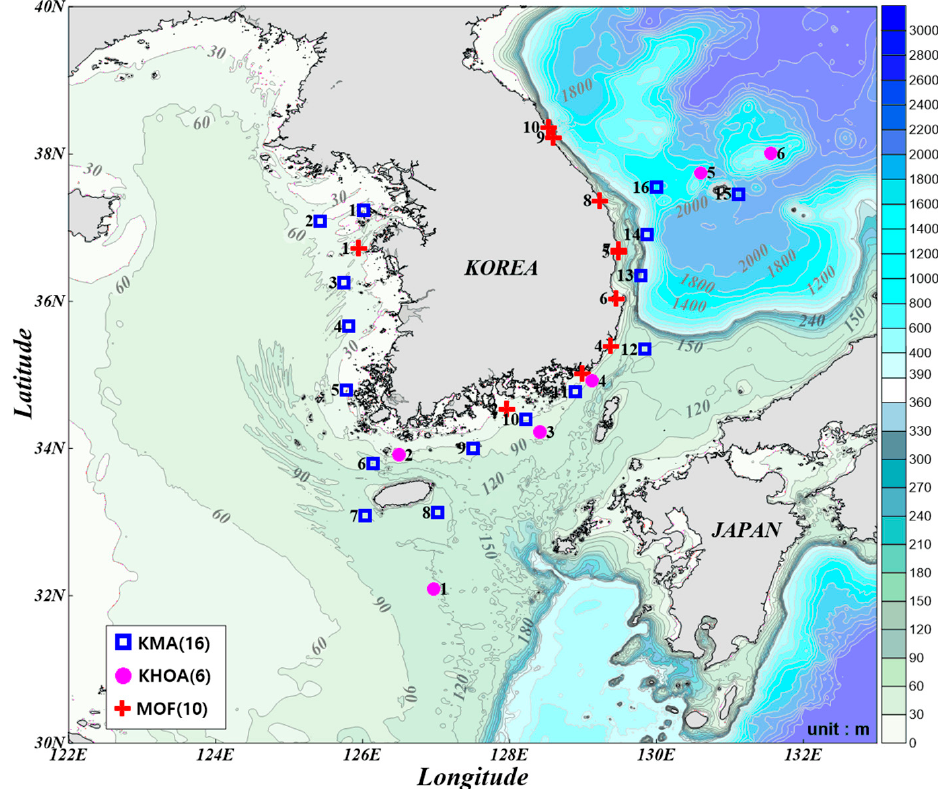
Figure 1. Locations of wave observation stations around Korean Peninsula provided by the Wave Information Network of Korea (WINK) system.